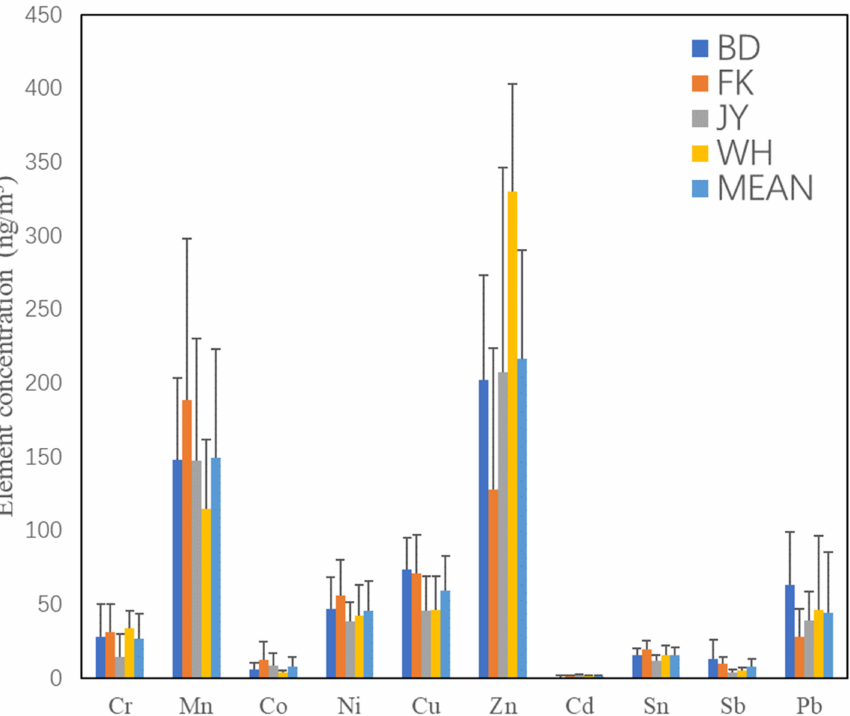
Figure 2. Concentrations of the heavy metal elements measured in the samples collected at the four road environment sampling sites in